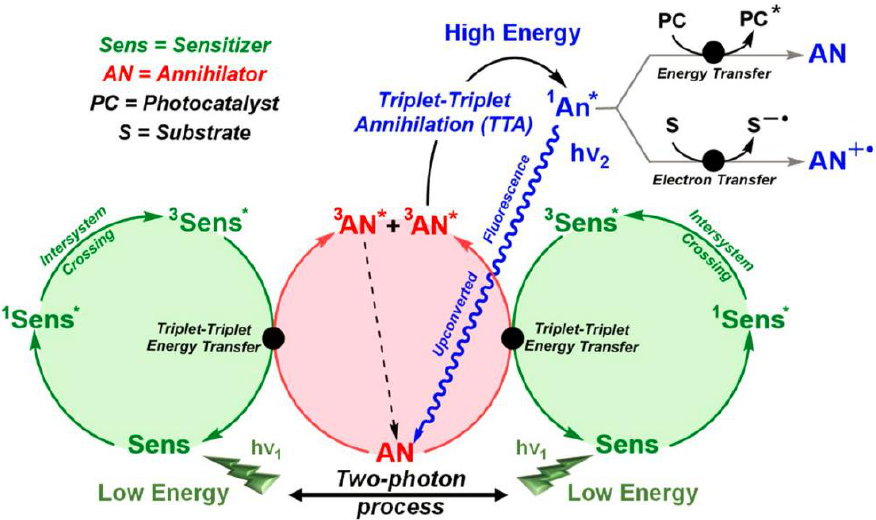
Figure 1. Schematic mechanisms of the TTA-UC process and its potential application for photochemical reactions, in which the symbol * refers to the excited state. Reprinted with permission from ref. [31]. Copyright 2022 Springer Nature.